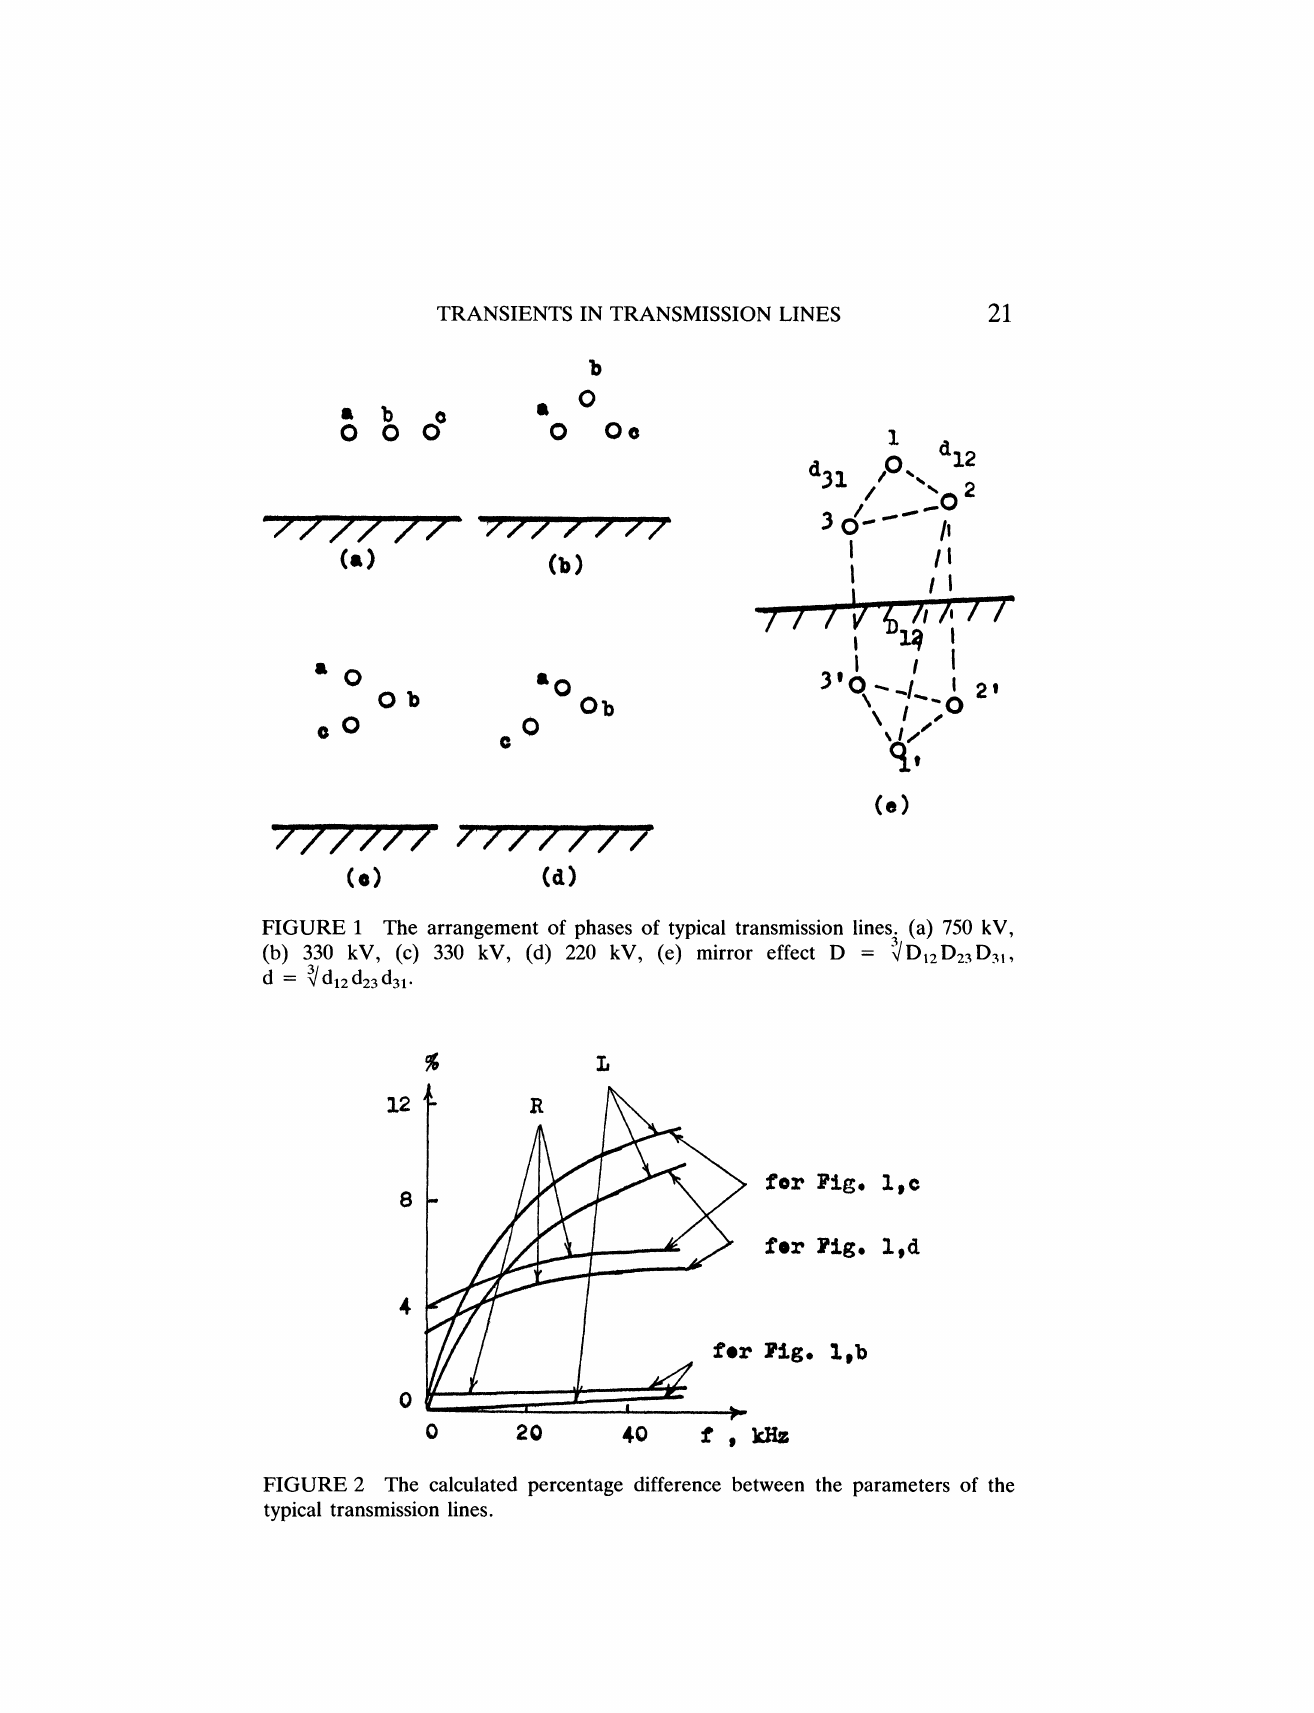
FIGURE 2 The calculated percentage difference between the parameters of the typical transmission